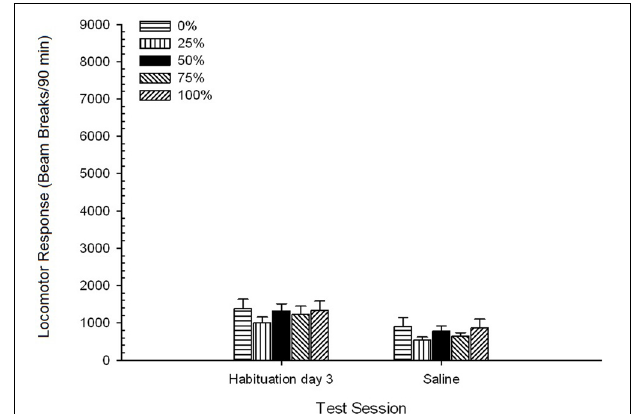
FIGURE 4 | Mean (SE) locomotor response (number of beam breaks in an electronic array per 90min) on the last of 3 drug-free habituation sessions and on a subsequent session after saline injection (i.p., 1ml/kg) in groups of Sprague Dawley rats ( n = 8/group) previously exposed to 15 daily conditioning sessions with sucrose reward (10% solution) delivered under 0, 25, 50, 75, or 100% variable schedules. The conditioned stimulus was a light (120s). Group 0 received the same number of rewards as group 100 in the absence of conditioned stimuli.